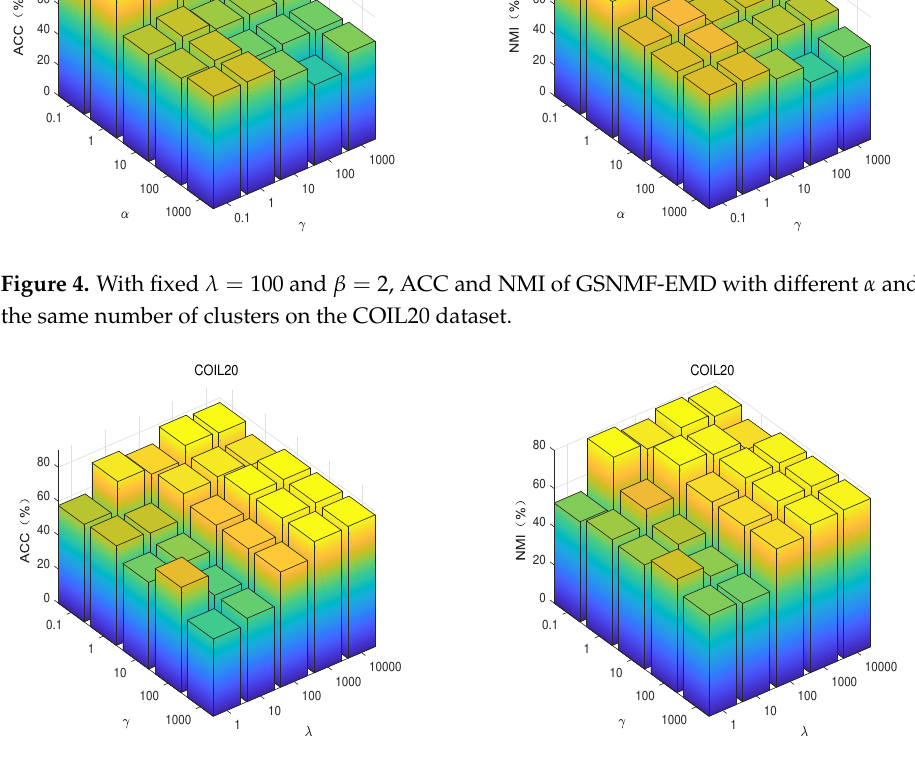
Figure 5. With fixed α = 10 and β = 2, ACC and NMI of GSNMF-EMD with different γ and λ , and the same number of clusters on the COIL20